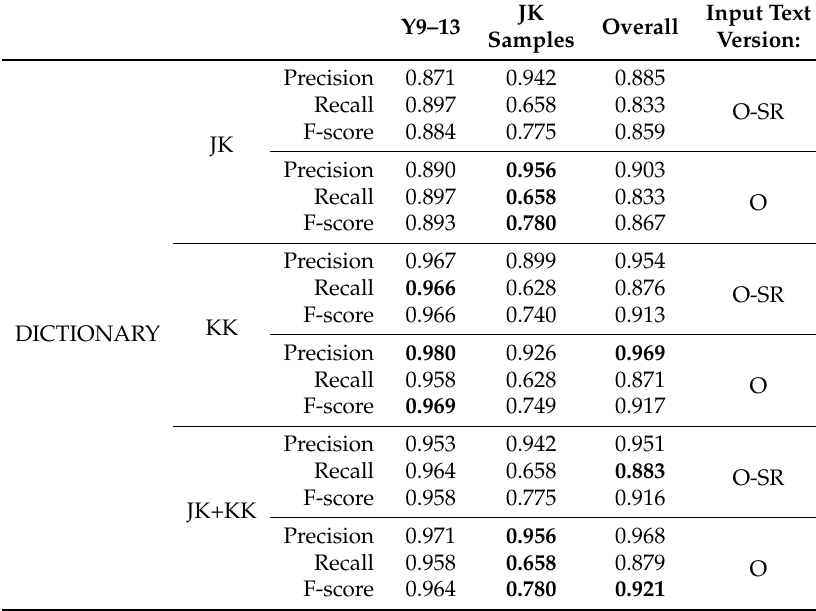
Table 11. Transcription normalization experiment results (best results in